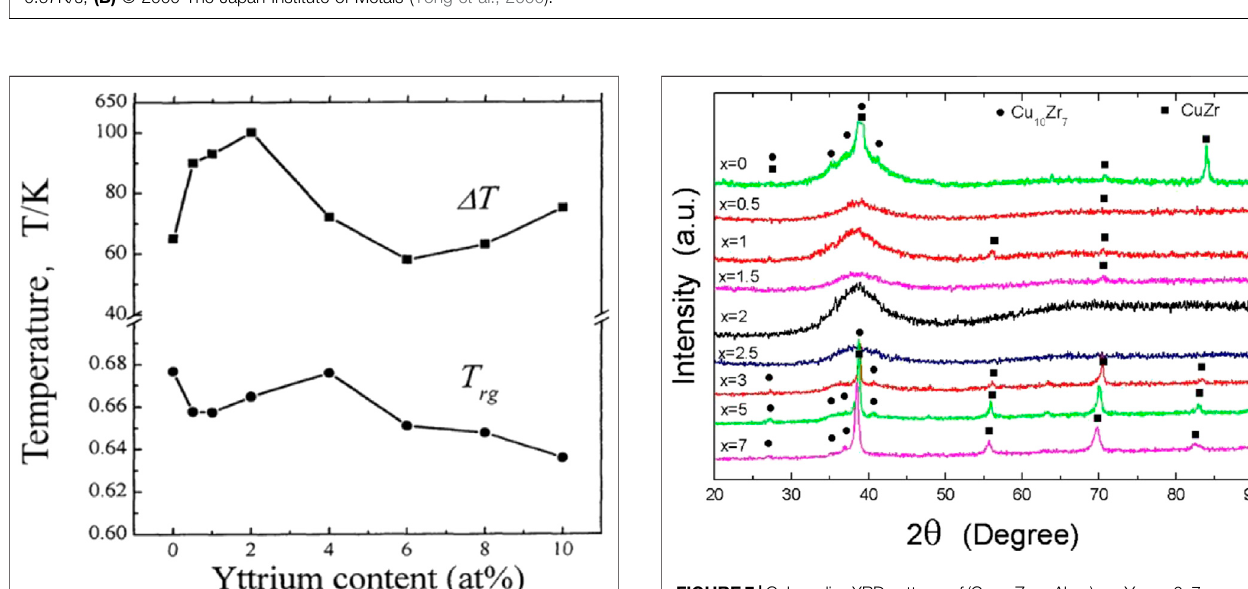
FIGURE7| ColoronlineXRDpatternsof(Cu 0.48 Zr 0.48 Al 0.04 ) 100- x Y x ,x (cid:1) 0 – 7 at.% alloys with a diameter of 3 mm. The crystalline phases are identi fi ed to be CuZr and Cu 10 Zr 7 phases. © 2006 American Institute of Physics (Zhang et al.,